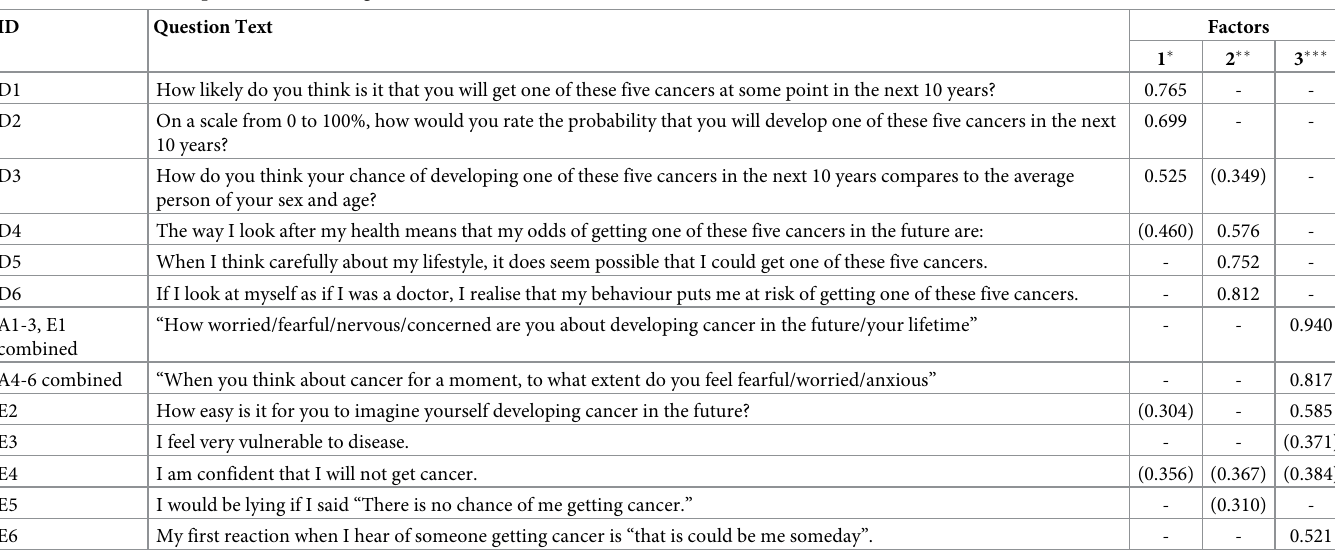
Table 4. EFA factor composition and